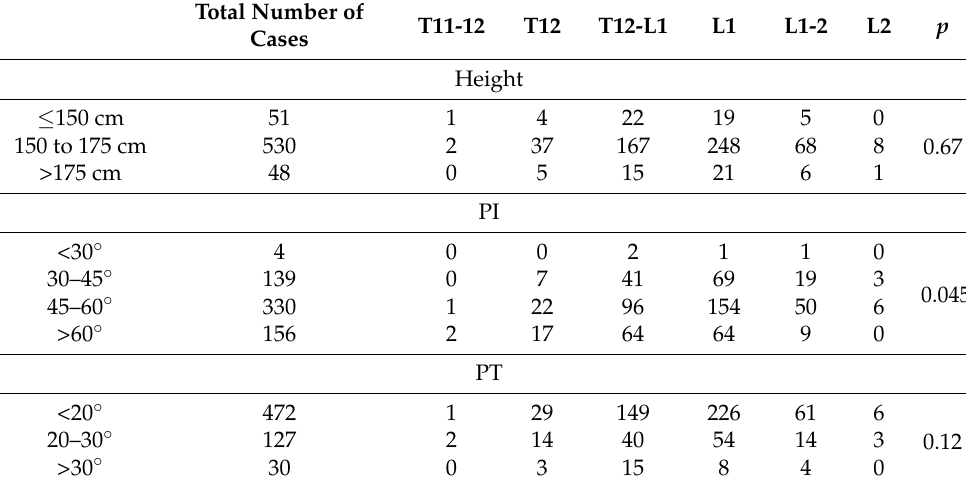
Table 3. The distribution of each factor at the different levels of conus